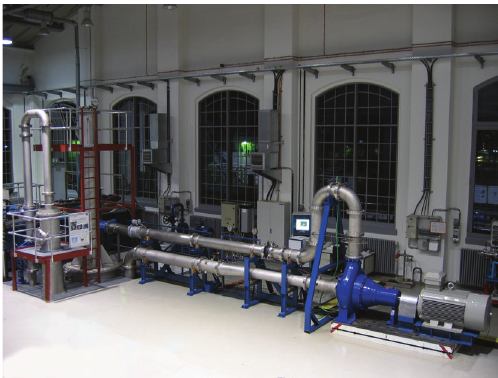
Figure 1: Sewage station with sewage pumps.